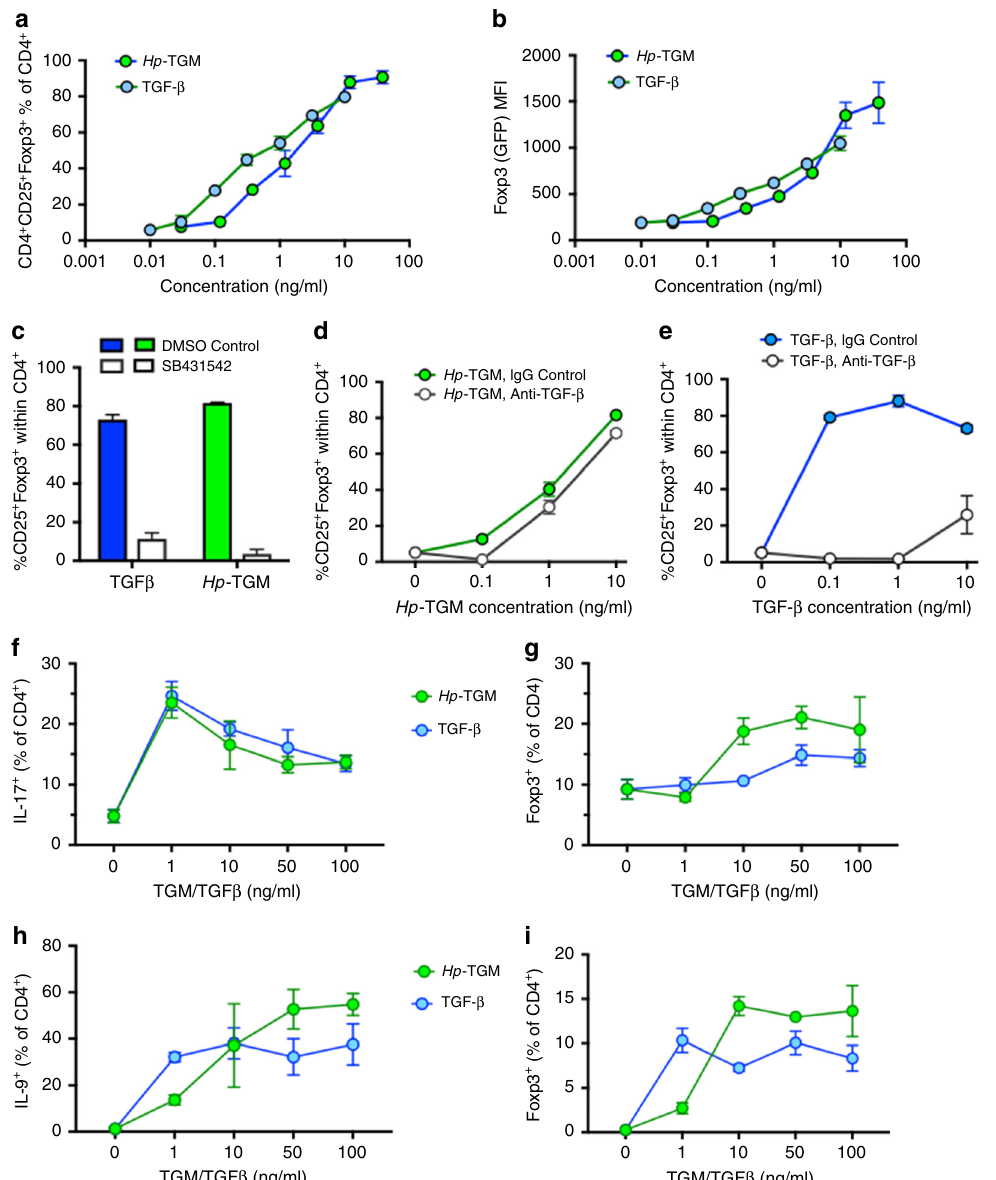
Fig. 4 Hp- TGM induces T cell Foxp3 expression even in proin fl ammatory conditions. a , b CD4 + CD25 – GFP – CD62L hi murine naive T cells were stimulated with plate-bound anti-CD3/CD28 for 4 days in culture with 100 U/ml IL-2 and variable concentrations of Hp- TGM or hTGF- β 1, before fl ow cytometric analysis of CD4, CD25 and Foxp3 expression; 2 technical replicates per concentration; representative of 4 independent experiments;. a : percentage of CD25 + Foxp3 + cells among total CD4 + cells; b , Mean fl uorescence intensity (MFI) of Foxp3 among Foxp3 + cells. Gating strategy is shown in Supplementary Fig. 6. c – e Foxp3 induction in the same conditions as a , in the presence of SB431542 inhibitor c or pan-vertebrate anti-TGF- β d , e ; 2 technical replicates per concentration; representative of 3 independent experiments. Analysis by multiple t tests showed no signi fi cant difference in responses to TGM when anti- TGF- β was present, but signicant effects ( p < 0.01) on responses to all concentrations of TGF- β . f , g Magnetically sorted murine CD4 + T cells were cultured for 5 days with Th17-promoting ligands (100 ng/ml IL-6, 5 ng/ml IL-23, 10 ug anti-IFN- γ ), together with the indicated concentrations of Hp -TGM or TGF- β , then stimulated with PMA/ionomycin in the presence of Brefeldin A for 4.5 h before staining for intracellular Foxp3 and IL-17. Data are mean ± SEM of triplicate replicates from 1 of 2 independent experiments; data were analysed by multiple t tests which showed no signi fi cant difference at any concentration of TGF- β v TGM for percentage IL-17 + , and p < 0.001 and p < 0.01, respectively for 10 and 50 ng/ml TGM v TGF- β for percentage Foxp3 + . Gating strategy is shown in Supplementary Fig. 6. h , i Murine CD4 + T cells were cultured as above with but with Th9-promoting ligands (40 ng/ml IL-4, 20 ng/ml IL-2), and assayed as above after 4 days of culture by staining for intracellular Foxp3 and IL-9. Data are mean ± SEM of three replicates from 1 of 2 independent experiments; data were analysed by multiple t tests which showed p < 0.05 for 1 ng/ml TGF- β v TGM for percentage IL-9 + , and p < 0.001 for 10, 50, and 100 ng/ml TGM v TGF- β for percentage Foxp3 + . Gating strategy is shown in Supplementary Fig.